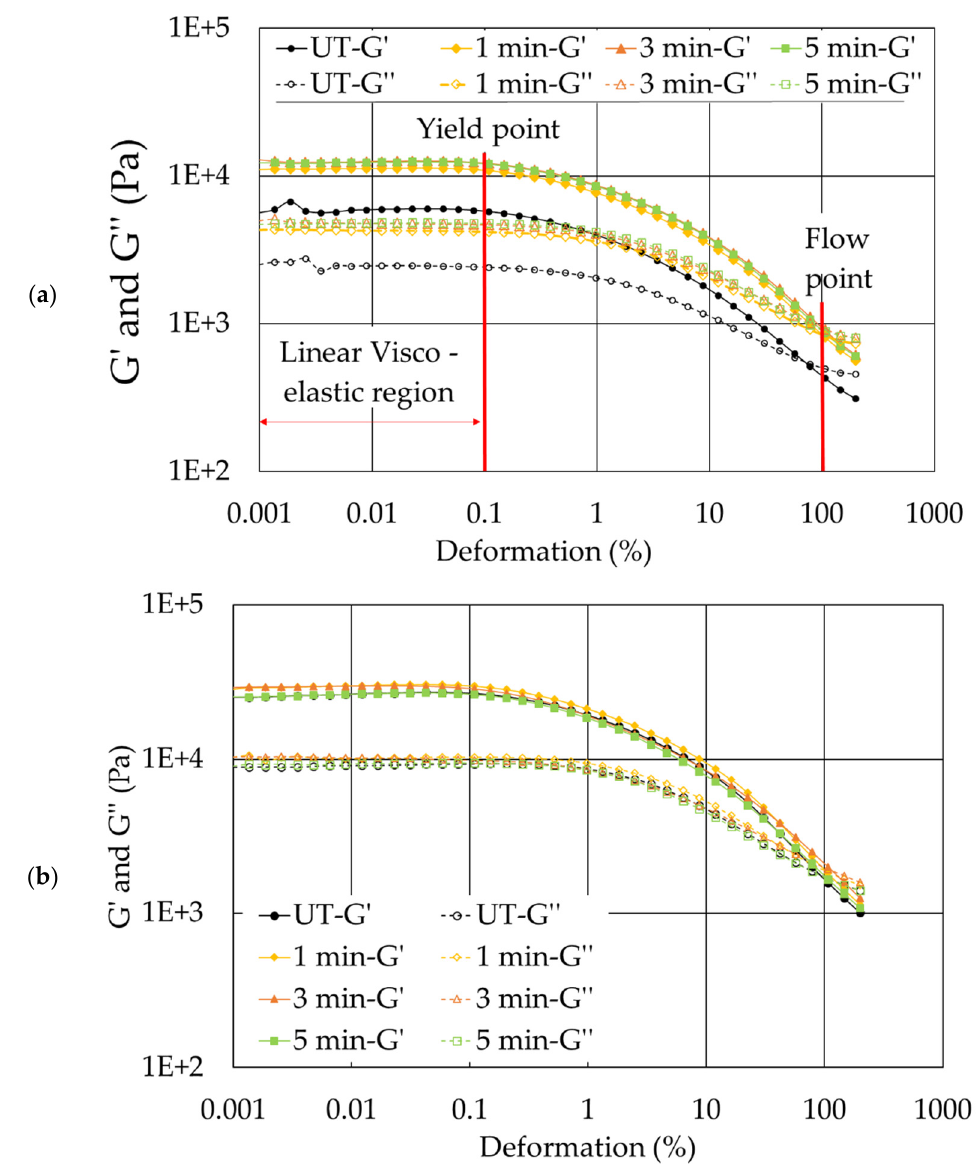
Figure 5. Change in the storage (G ′ ) and loss (G ′′ ) moduli of wheat dough as a function of NTP treatment time: ( a ) for the flour type 550; ( b ) for the flour type 1050.